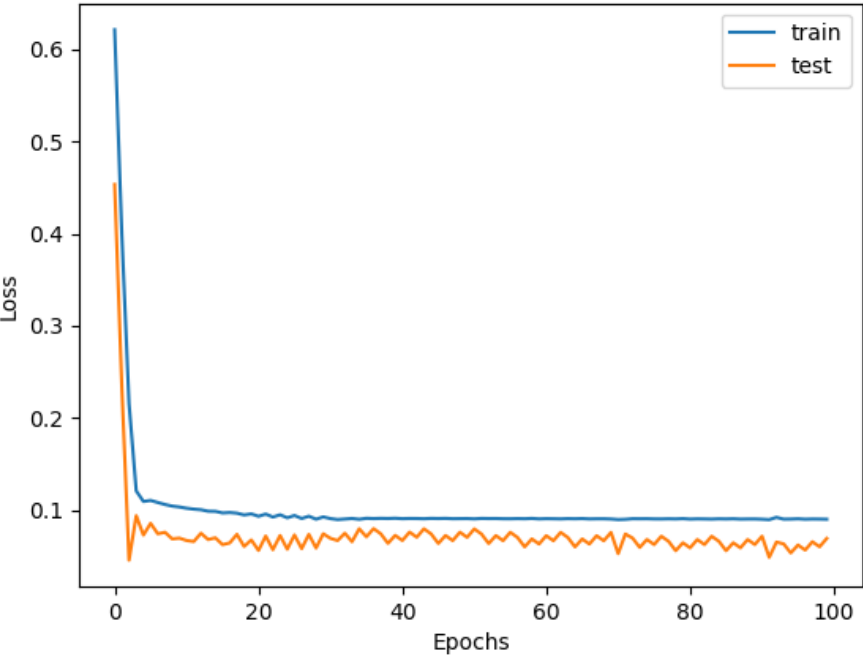
Figure 12. The loss curve vs. epochs of the training and testing process.